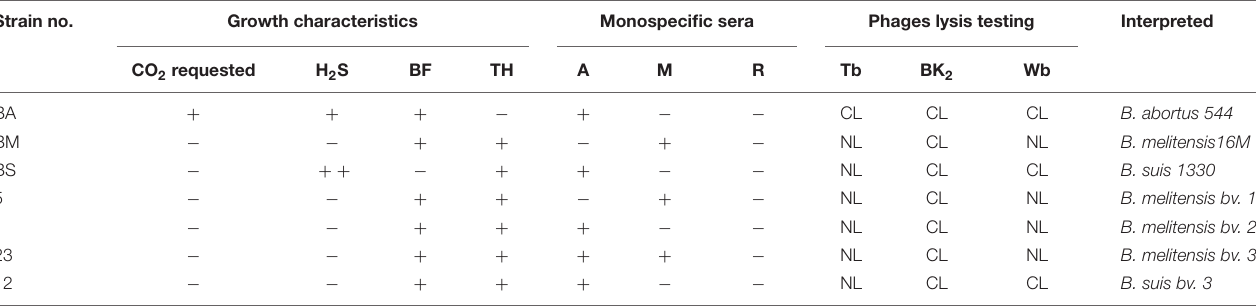
TABLE 1 | Biotyping characteristics of Brucella species isolates in Hainan Province, China. Strain no.